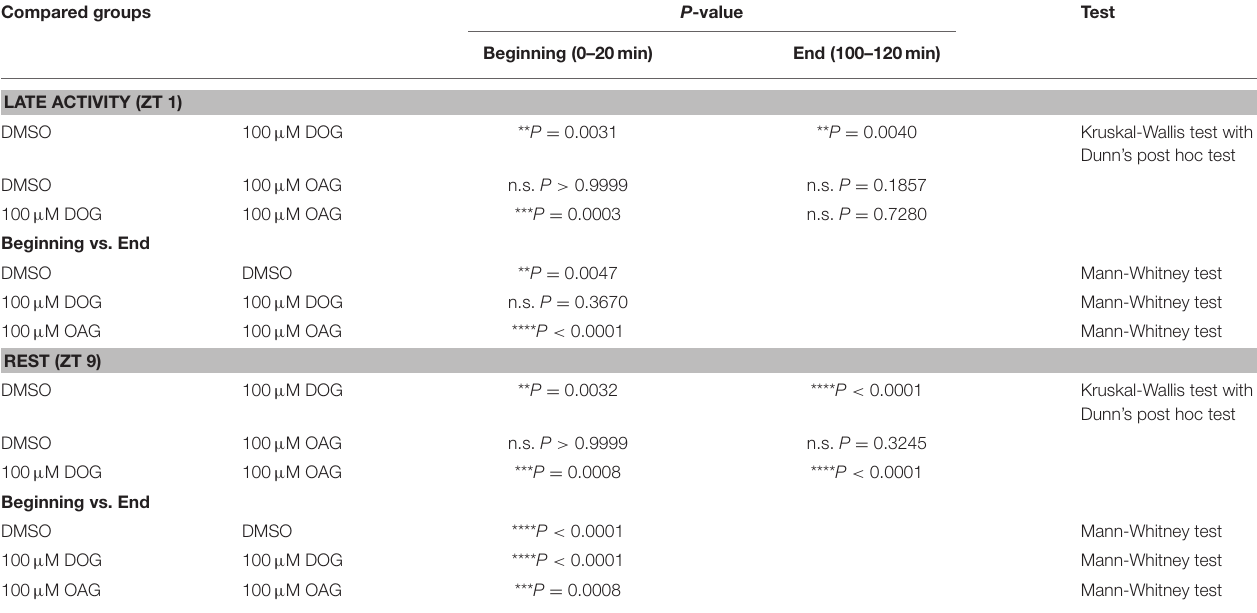
TABLE 5 | Statistical analysis of the late, long-lasting pheromone response in the presence or absence of 100 µ M DOG or OAG during the late activity phase and at rest ( Figure 8 ). Compared